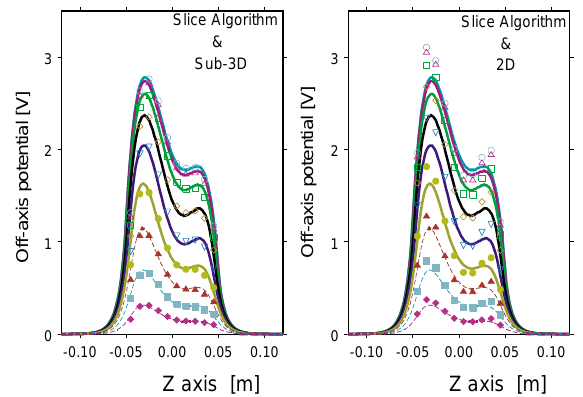
FIG. 9. (Color) On the left-hand side is the longitudinal potential of the beam bunch of Fig. 1 inside a metal pipe of radius 4 cm calculated by the slice algorithm of Sec. II (solid and dashed lines) and the sub-3D Poisson solver (symbols) for 0 # r # 4 cm. On the right-hand side are the results of the sub-3D Poisson solver (symbols), but neglecting the ≠ 2 u (cid:3) ≠ z 2 correction term.